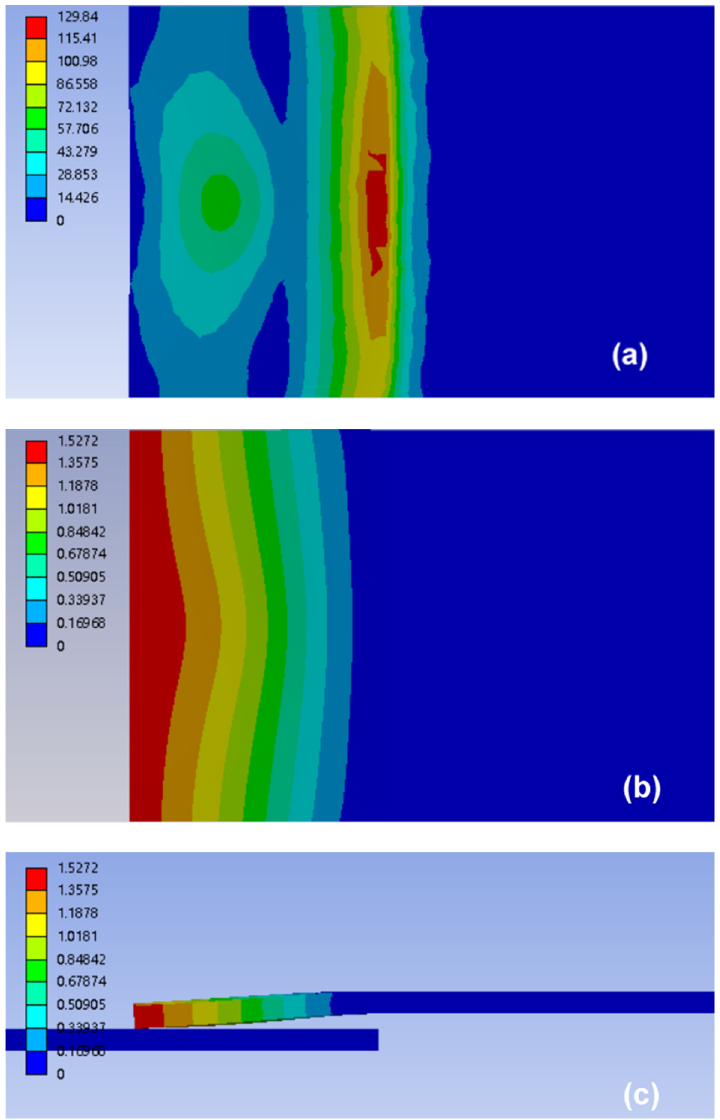
Figure 13. Simulation of stress and deformation of the upper workpiece for joint with gap of 1.5 mm under static pressure and preload: ( a ) stress distribution of the upper workpiece (Units in MPa), ( b ) top view, and ( c ) side view of the deformation distribution of the upper workpiece (Units in mm).